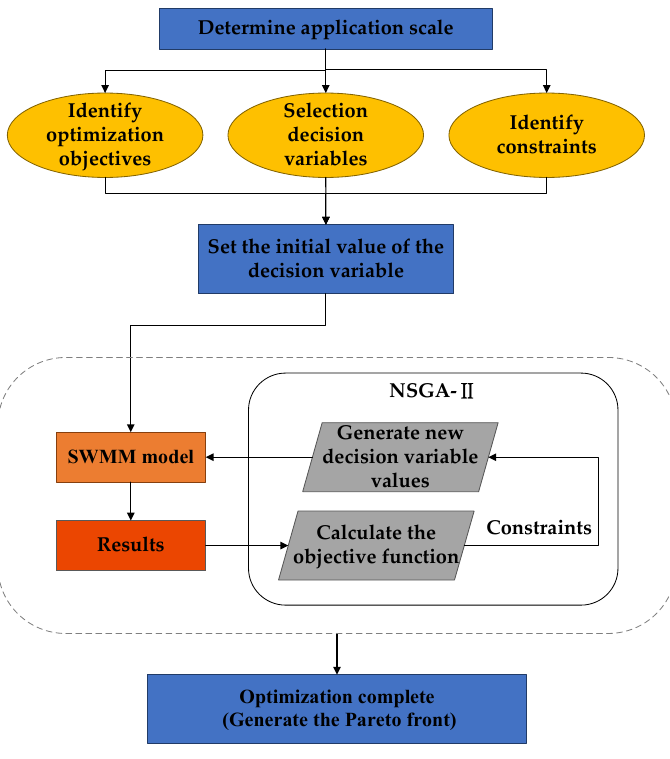
Figure 9. Schematic of the GI optimization procedure.